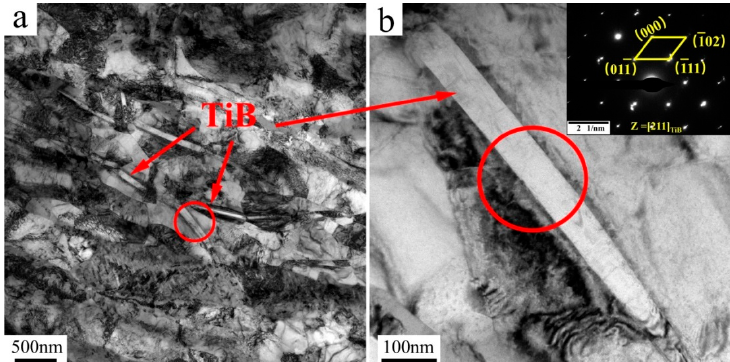
Figure 9. TEM images and SAED pattern of the TiB phase within the TiFeB alloy annealed at 450 °C for 1 h. ( a ) TEM images of the TiB phase; ( b ) SAED pattern of the circled TiB phase.